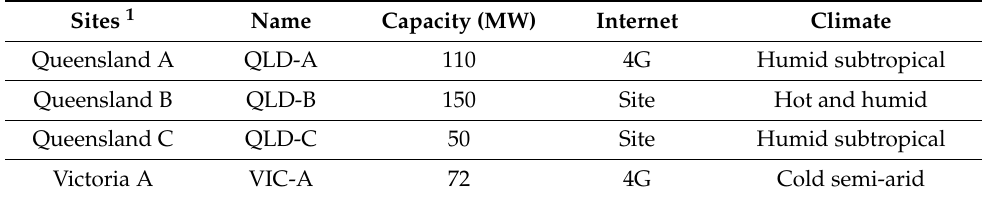
Table 1. Summary of solar